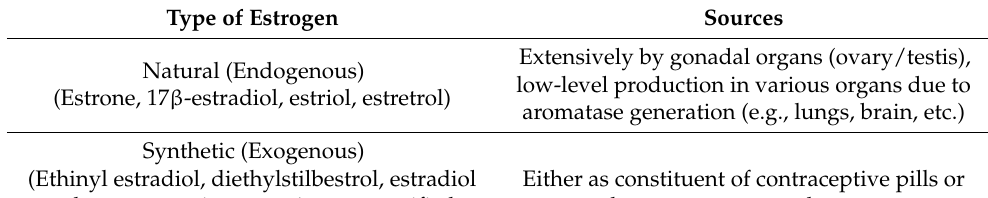
Table 1. The different sources of estrogens, distinguished via endogenous and exogenous origins.